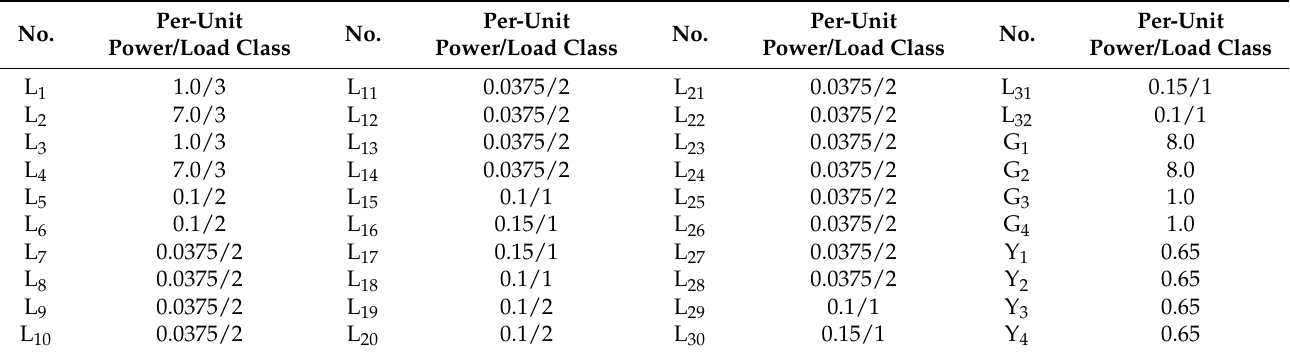
Table 1. Power parameters of the loads and generators